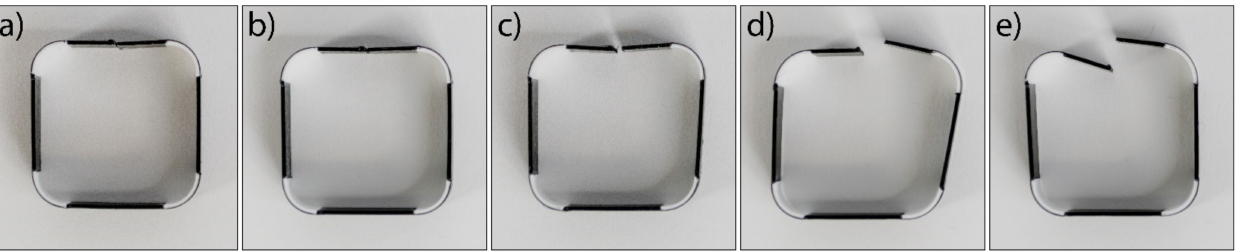
Figure 19. 3D printed test samples after shape transformation in water at 70 ◦ C: ( a ) and ( b ) ideal case; ( c ) small deflection of angle; ( d ) and ( e ) larger deflection of angle from 90 ◦